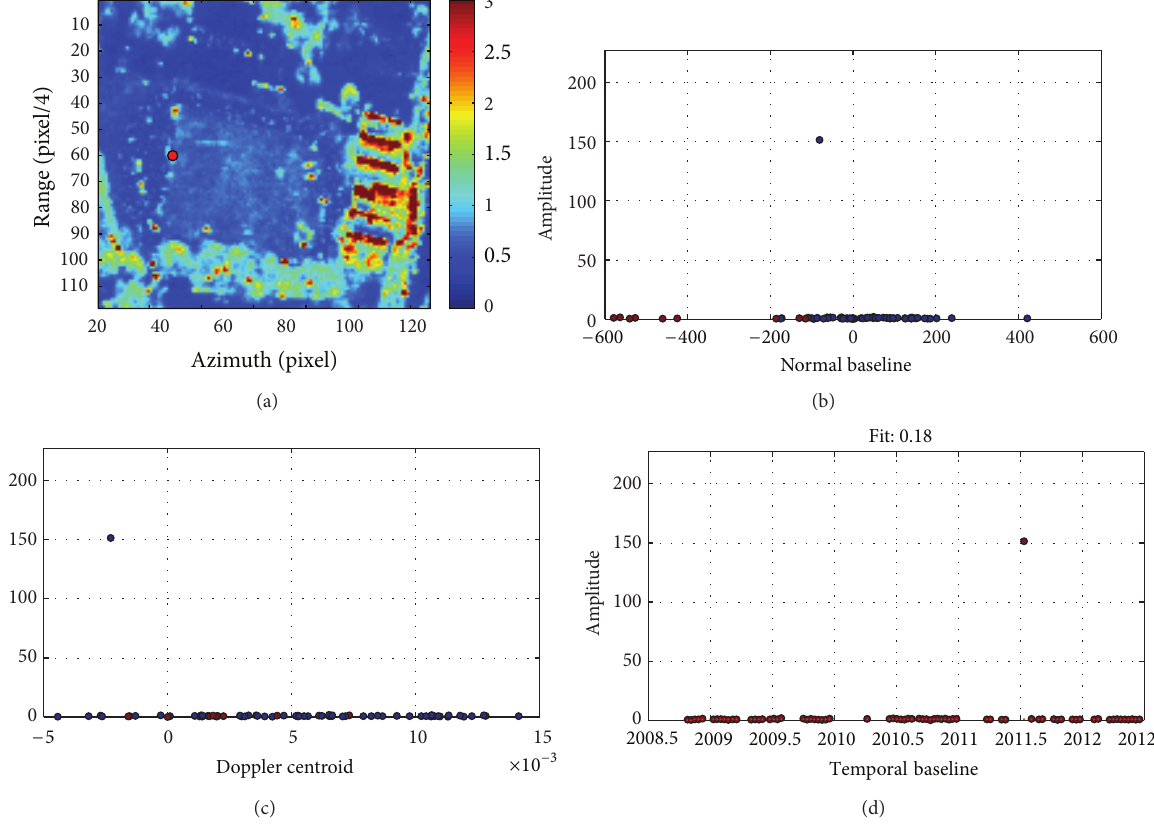
Figure 7: Amplitude Analysis of the bigger corner reflector. (a) shows the location of the reflector; (d) shows the amplitude time series of the location. The one outlined in the amplitude time series indicates the deployment and test of the